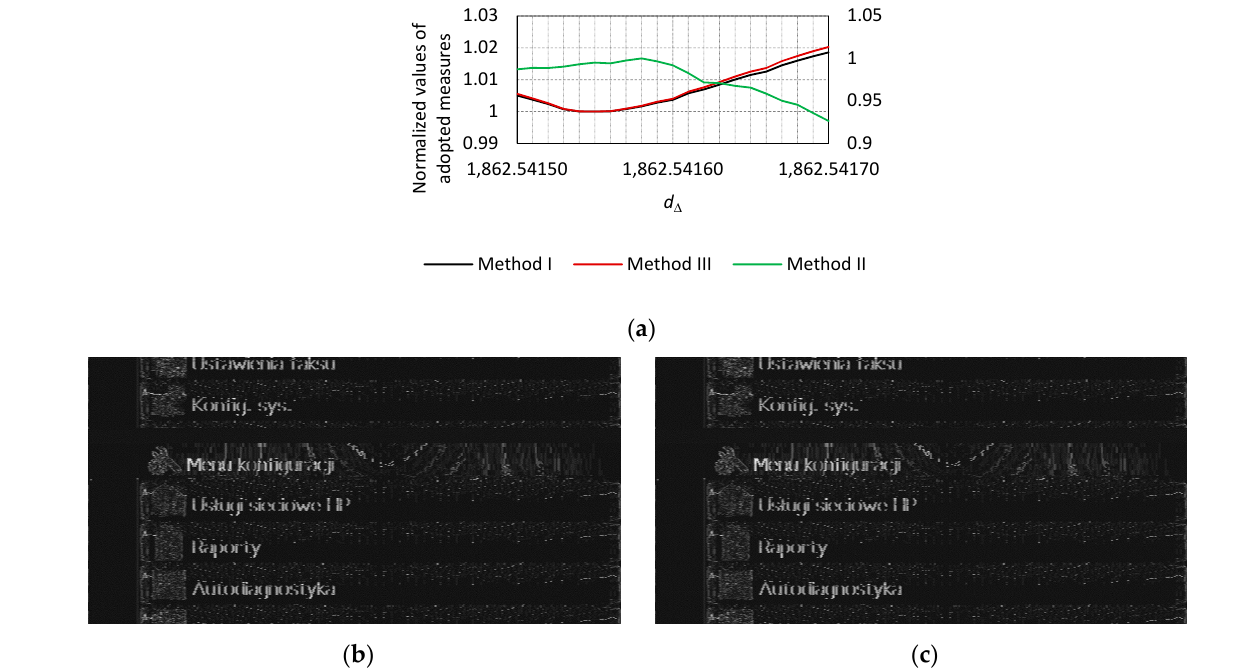
Figure 35. ( a ) The normalized values of the adopted measures (method I, II and III) calculated in domain of image line length d ∆ for the accuracy ∆ = 0.00001 (for the original image shown in Figure 7f) and images reconstructed on the basis of the recorded revealing emission signals at frequency f o = 235 MHz (receiving bandwidth BW = 10 MHz, accuracy ∆ = 0.00001), ( b ) for estimated line length d ∆ = 1862.54155 and ( c ) for estimated line length d ∆ = 1862.54158 —multiple of image summation Sum MTL = 15, the source of revealing signal emission—display of laser printer.